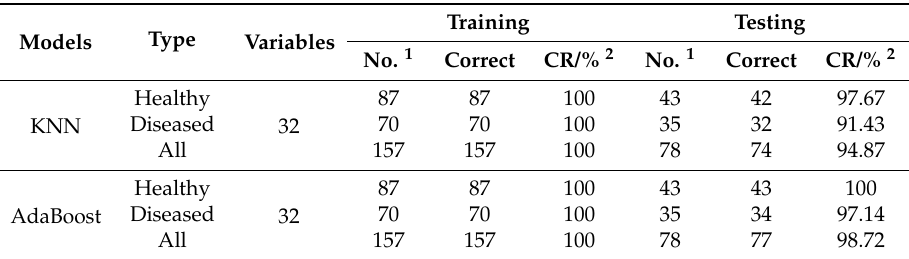
Table 3. Classification results based on gray images.